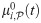
Representation of the variables of the distribution-moments equations.The variable μi,P0(t) (respectively, μi,N0(t)) corresponds to the fraction of permissive (respectively, non-permissive) BSs to which a MH is bound, while the ratio μi,P1(t)/μi,P0(t) (respectively, μi,N1(t)/μi,N0(t)) corresponds to the average XB distortion within the permissive (respectively, non-permissive) attached BSs.